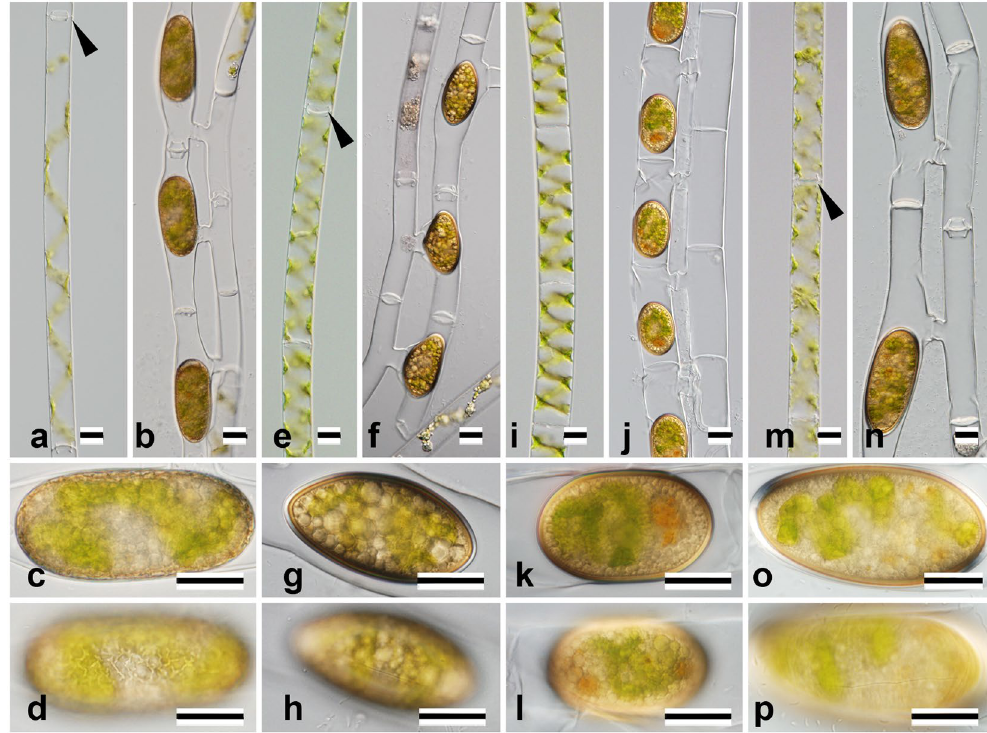
Figure 1. Nomarski interference micrographs of four species of Spirogyra belonging to Clade I (Fig. 5a, Table 1). Scale bars = 20 μ m. ( a – d ) S . dentireticulata chiA101 (JPS003). ( e – h ) S . hopeiensis biw0302 (JPS004). ( i – l ) S . longata chiA305 (JPS005). ( m – p ) S . semiornata chiA304 (JPS014). ( a , e , i , m ) Vegetative cells. Arrowheads indicate replicate walls. (b , f , j , n) Formation of zygospores. ( c , g , k , o ) Optical section of zygospore. ( d , h , l , p ) Surface view of